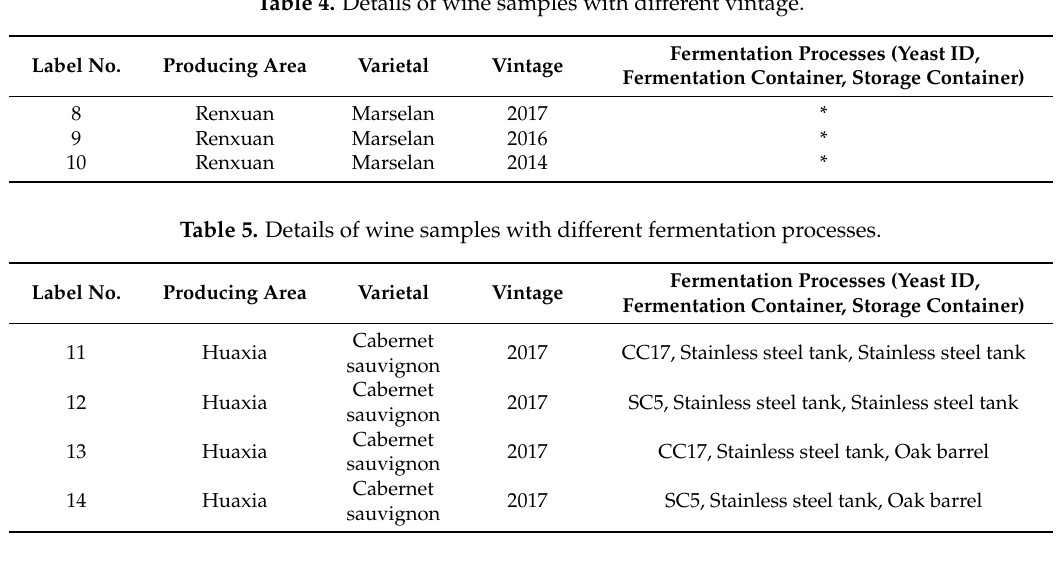
Table 4. Details of wine samples with different vintage.